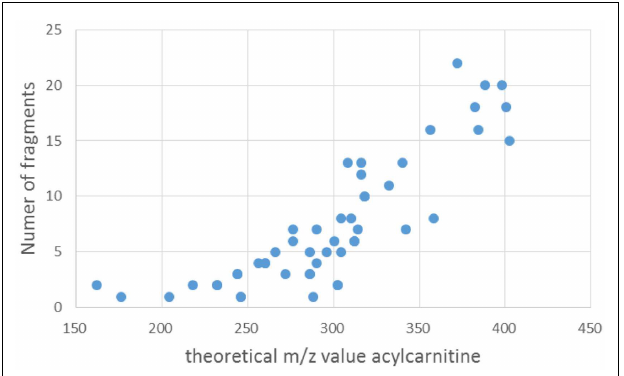
FIGURE 9 | Scatterplot of the number of fragments counted between m / z 85 and the mass value of the precursor ion (i.e., fragmented annotated acylcarnitine) vs. the theoretical mass value of the acylcarnitine in positive ionization mode